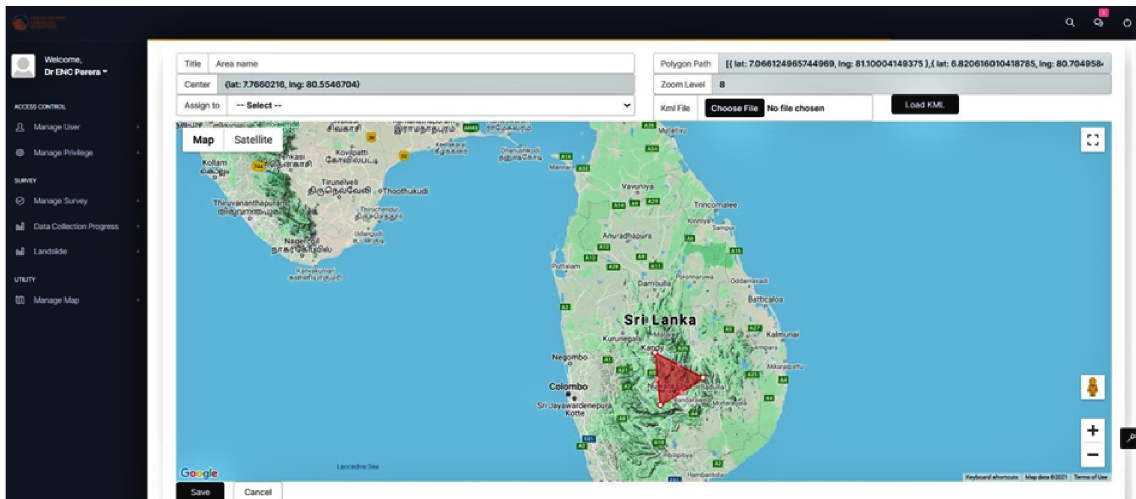
Figure 4: Adding spatial information to the inventory: landslide boundary demarcation tool in the PLI web